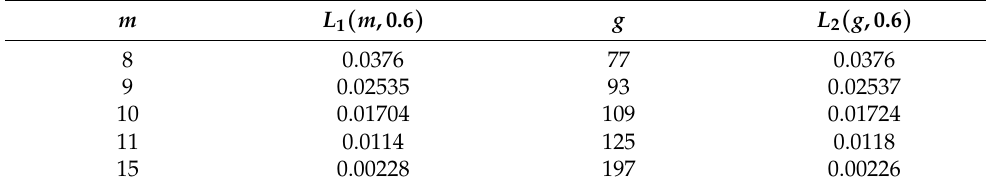
Table 1. Comparison of match win probabilities for g- and m-rules when p = 0.6. m L 1 ( m ,0.6